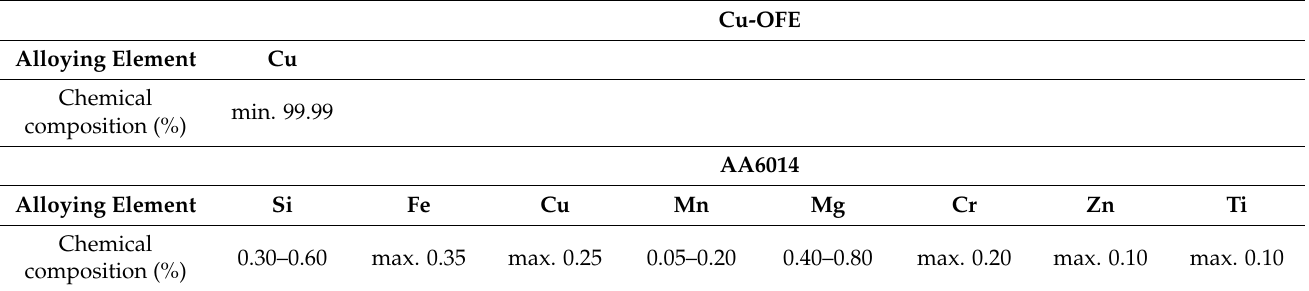
Table 2. Chemical composition of the used materials. Cu-OFE